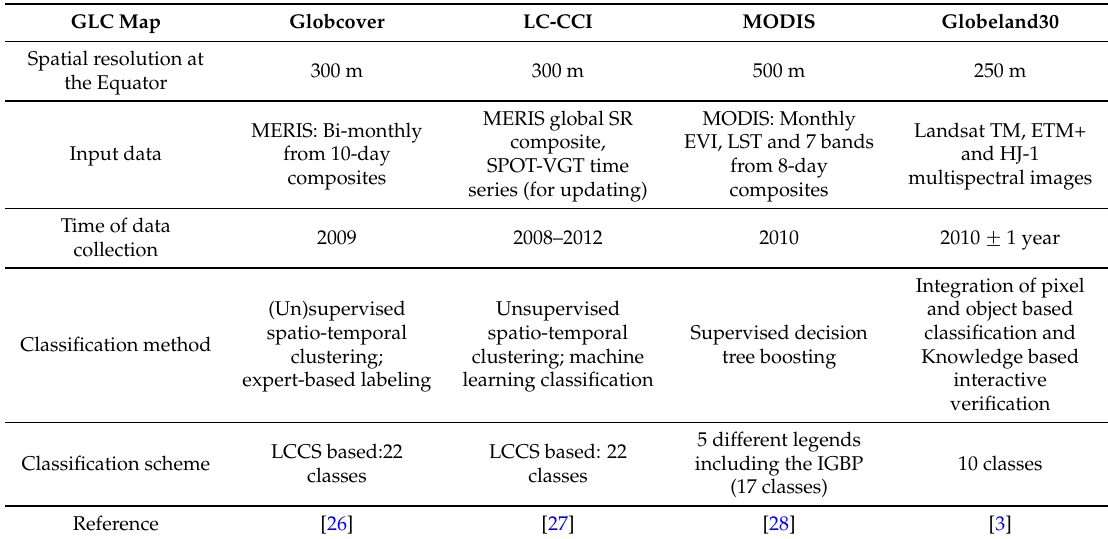
Table 1. A summary of GLC maps used for